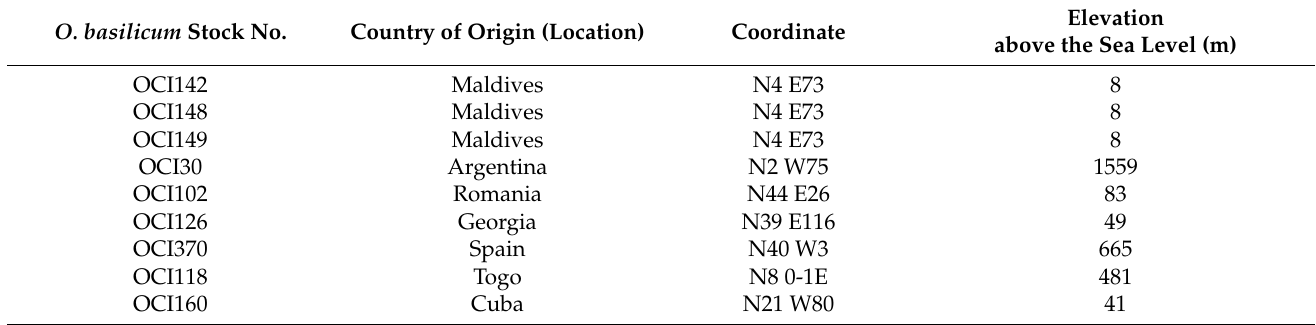
Table 1. O. basilicum accessions (ecotypes) and their geographical distributions. O. basilicum Stock